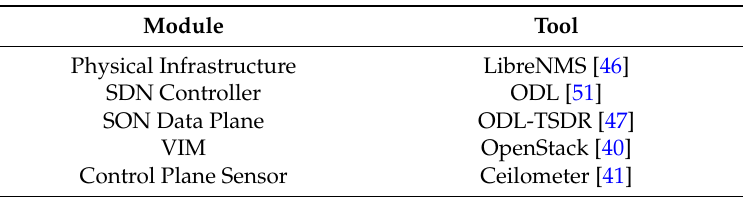
Table 10. Open Source